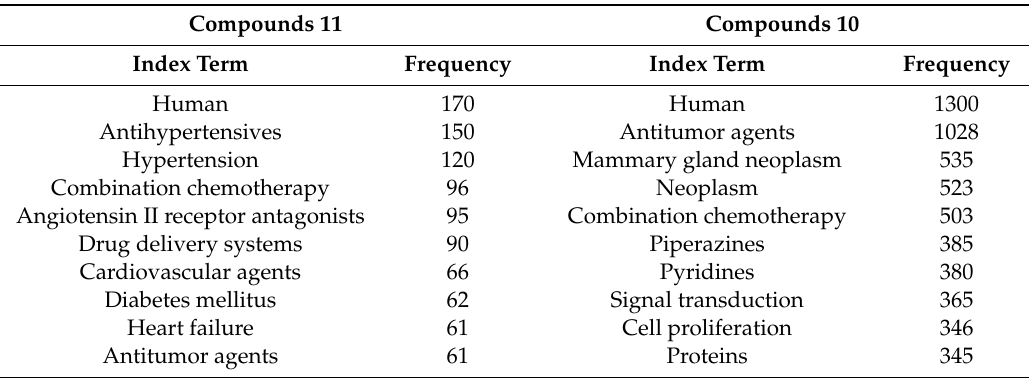
Table 4. Index terms in SciFinder for compounds 10 and 11